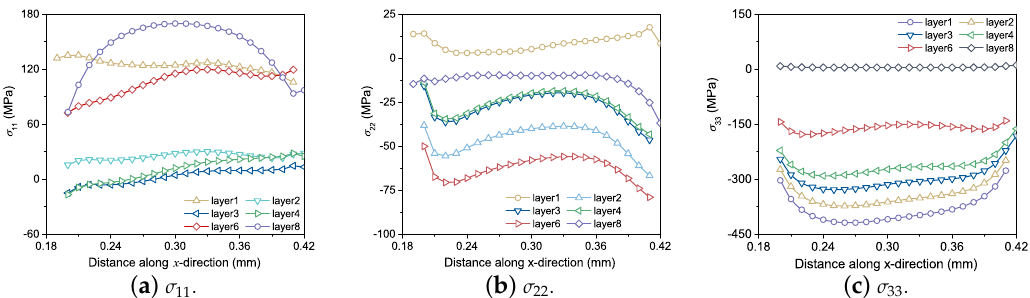
Figure 13. After printing of each layer, the distribution of ( a ) σ 11 , ( b ) σ 22 and ( c ) σ 33 . of each layer, layer i indicates the time when the printing of layer i ends.